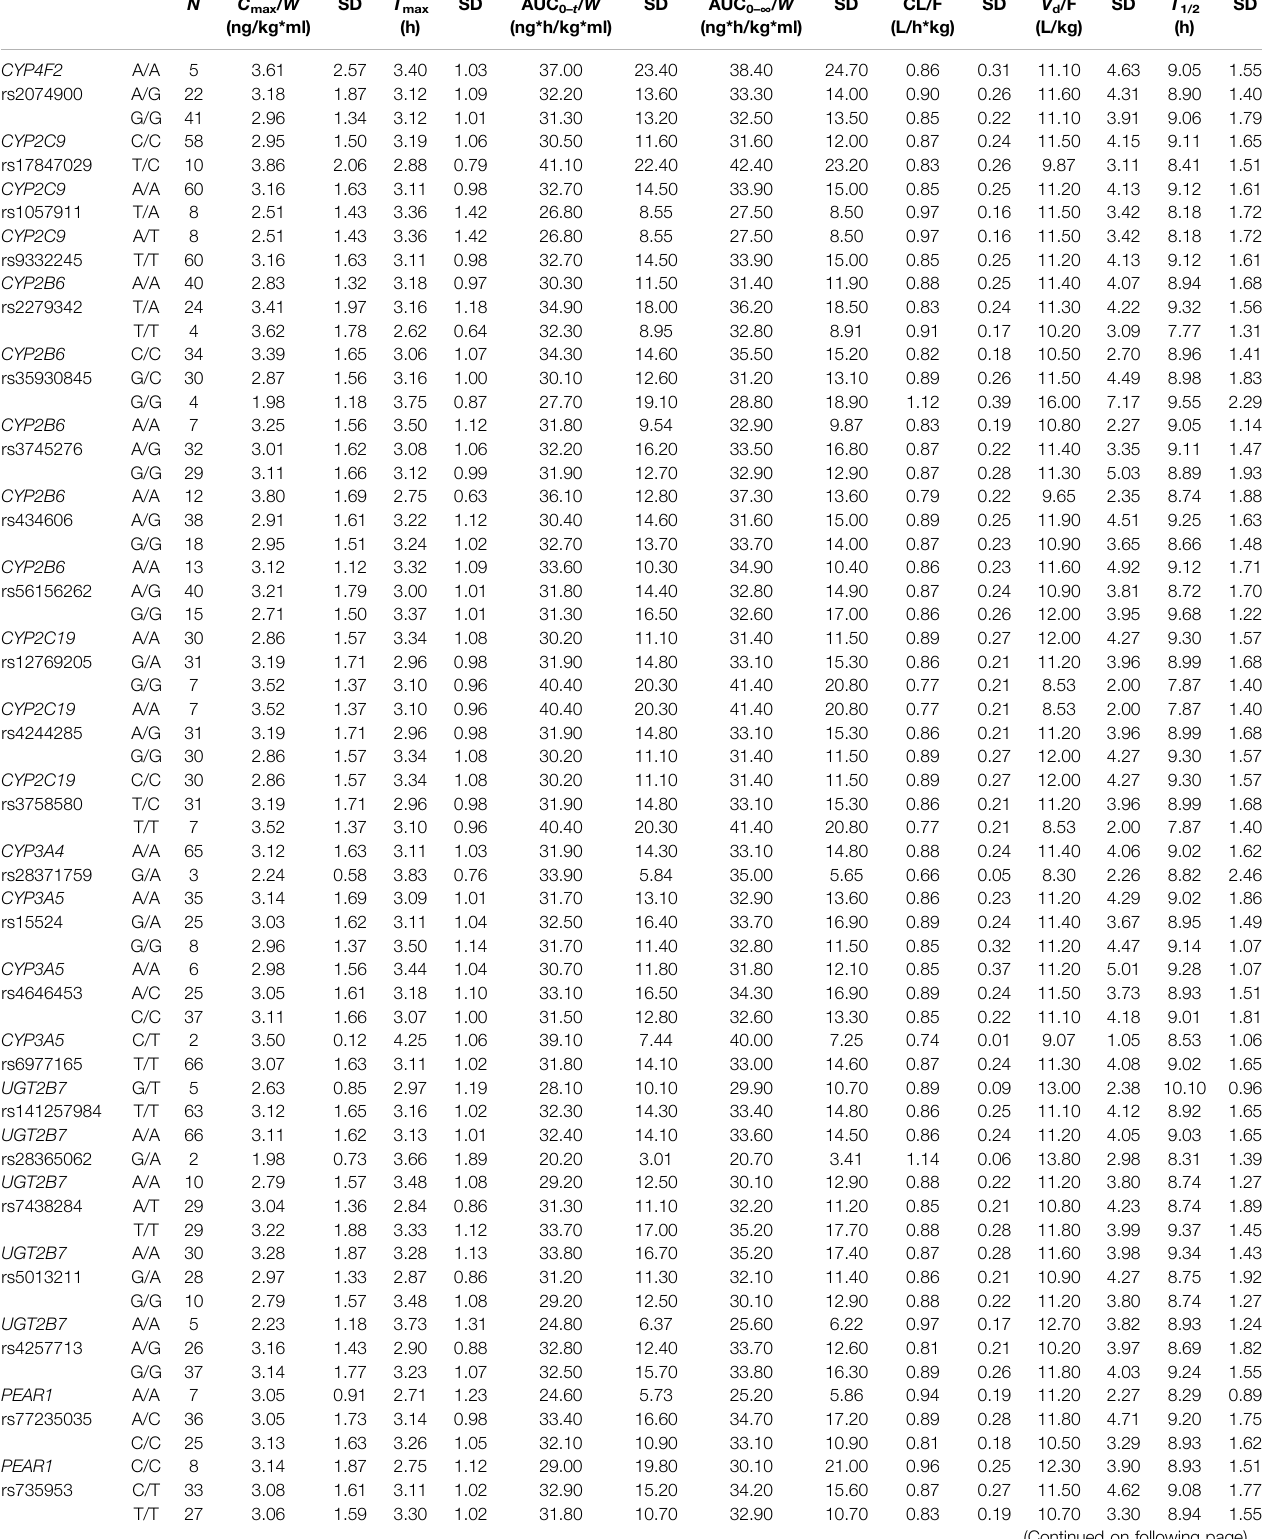
TABLE 5 | AR-C124910XX pharmacokinetic parameters based on genotypes without statistical signi fi cance